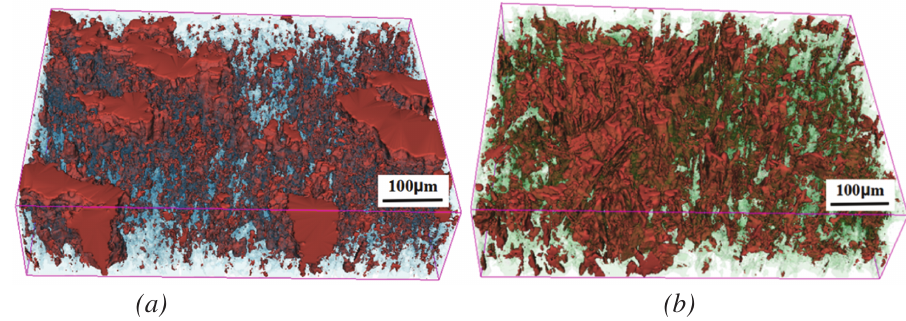
Figure 8: 3D perspective images of pore in